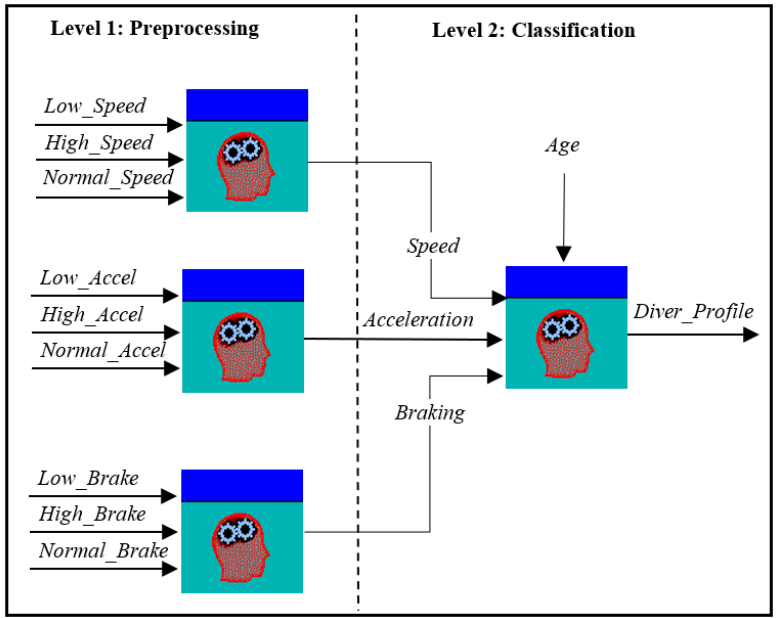
Figure 3. System